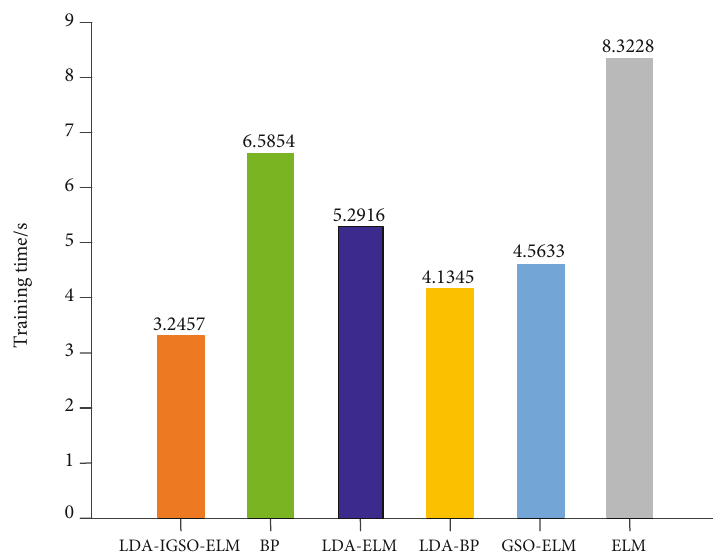
Figure 8: Comparison of training time of various